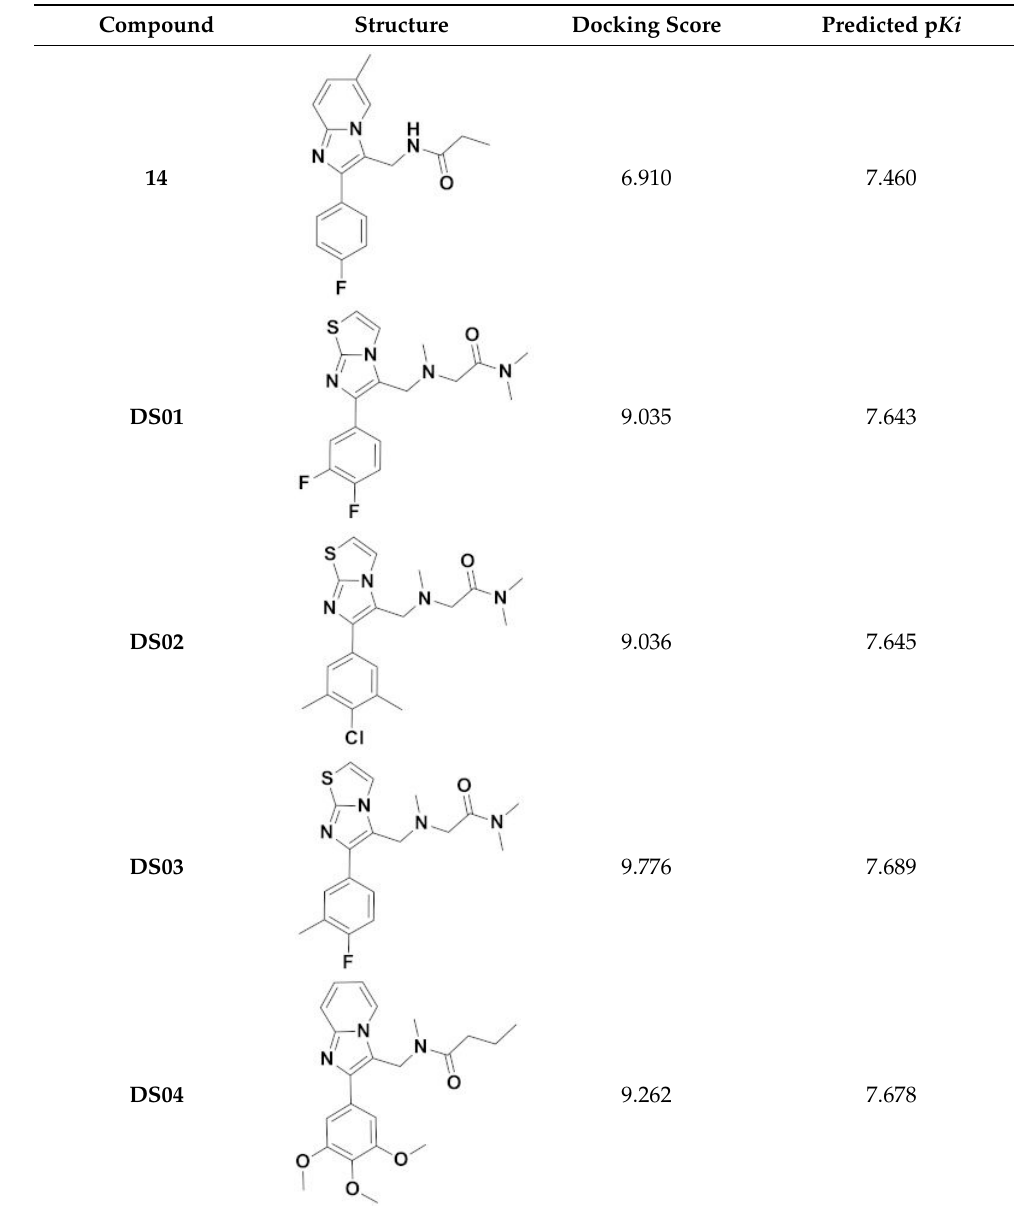
Table 6 summarizes the chemical structures of four hit compounds ( DS01–DS04 ) with their docking scores and predicted p Ki values, by the Topomer CoMFA model. The compounds DS03 and DS04 were selected for further study, as their predicted activities were higher than those of the other hit compounds and compound 14 . The docking results of compounds DS03 and DS04 in the BZD active site of human α 1 β 2 γ 2 GABA A R are depicted in Figure 12. It could be observed that the docking conformations of the compounds DS03 and DS04 were basically similar to that of compound 14. Table 6. Chemical structures, docking scores, and predicted p Ki values of the newly screened hit